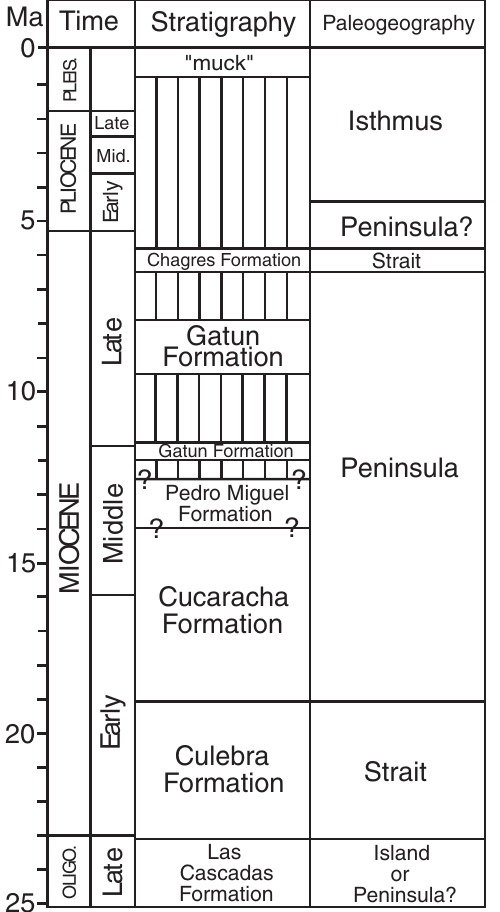
Figure 10. Geologic history of the Panama Canal Basin, showing geologic time, stratigraphy and paleogeography. Vertical lines represent a hiatus. Question marks under stratigraphy represent uncertainty in age. Time scale from Gradstein et al. [69]. Oligo.=Oligocene. Pleis.=Pleistocene.